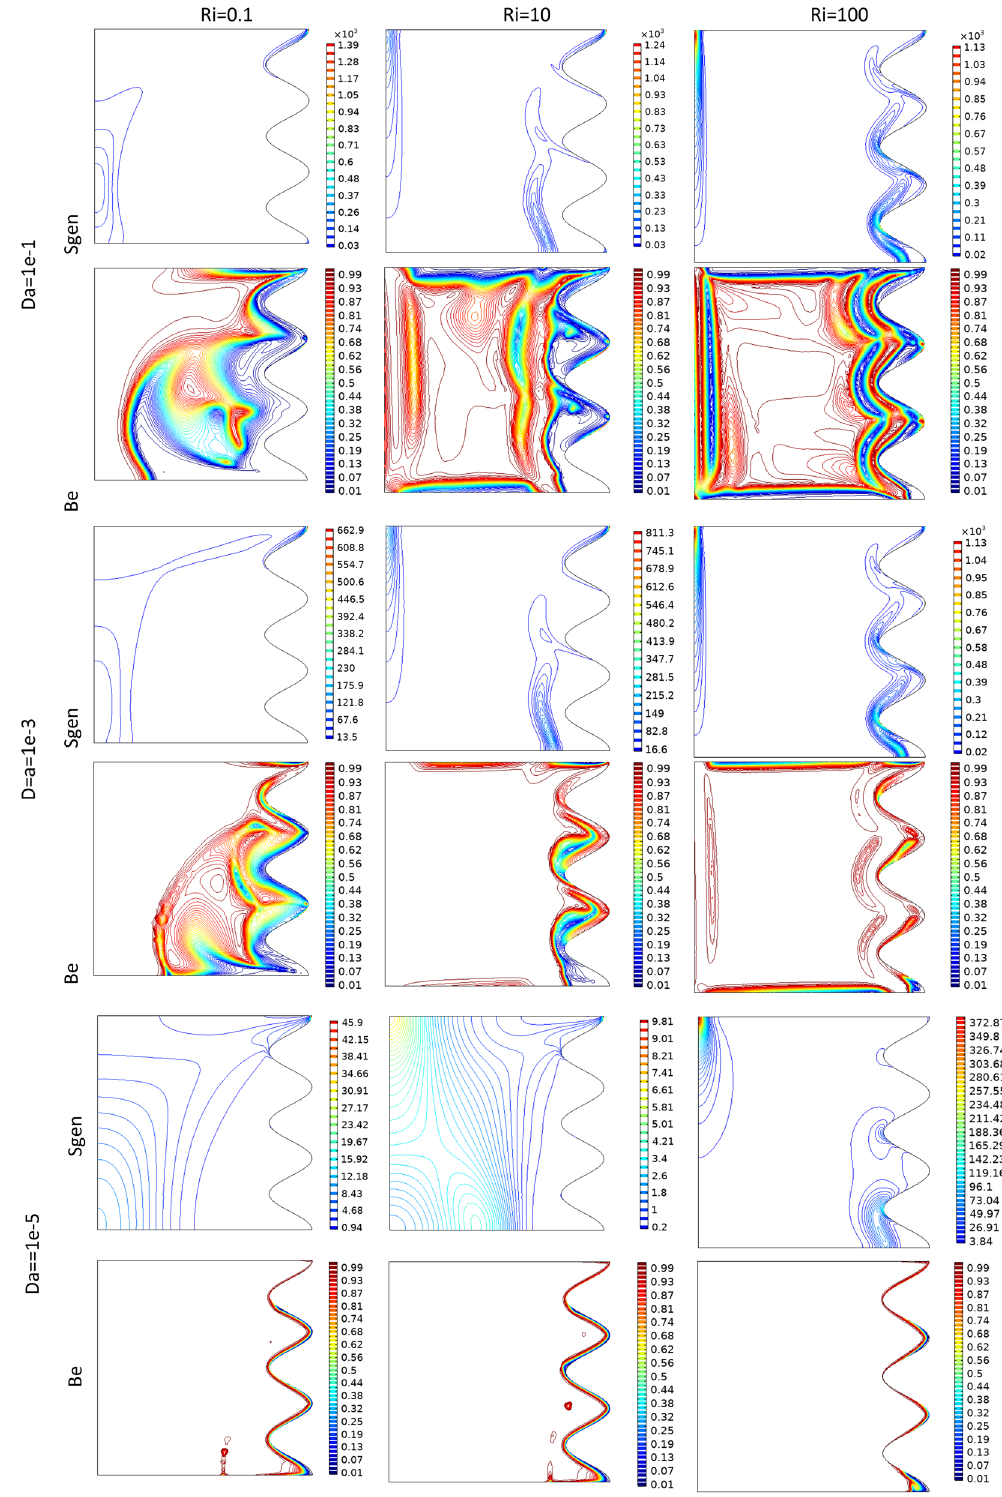
Figure 14. Bejan and Sgen numbers when Re = 200, Q = 3, φ = 0.02, Ha = 20, γ = 45, A = 0.1 for Case